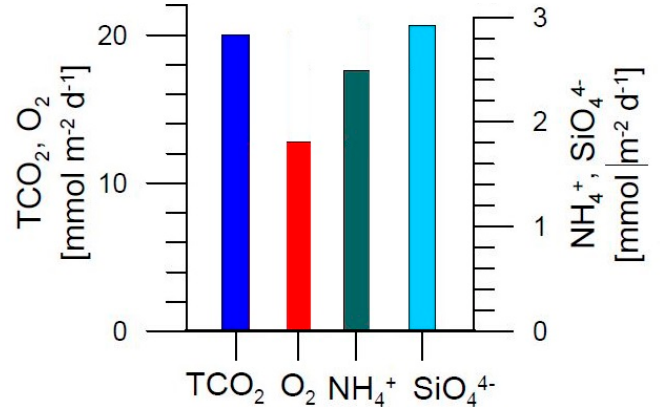
Figure 13. Average ( n = 3) organic matter (benthic nutrient), TCO 2 , O 2 , NH 4+ , and SiO 44 − in Wandandian delta. Note that NH 4+ , SiO 44 − , and TCO 2 were fluxing out of the sediment, whereas O 2 was fluxing into the sediment. TCO 2 was determined by alkalinity and conductivity titrations for this study site (after [14]).